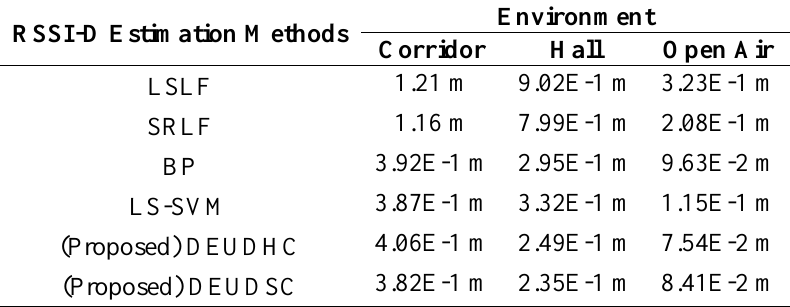
Table 7. The experimental results of different RSSI-D methods.